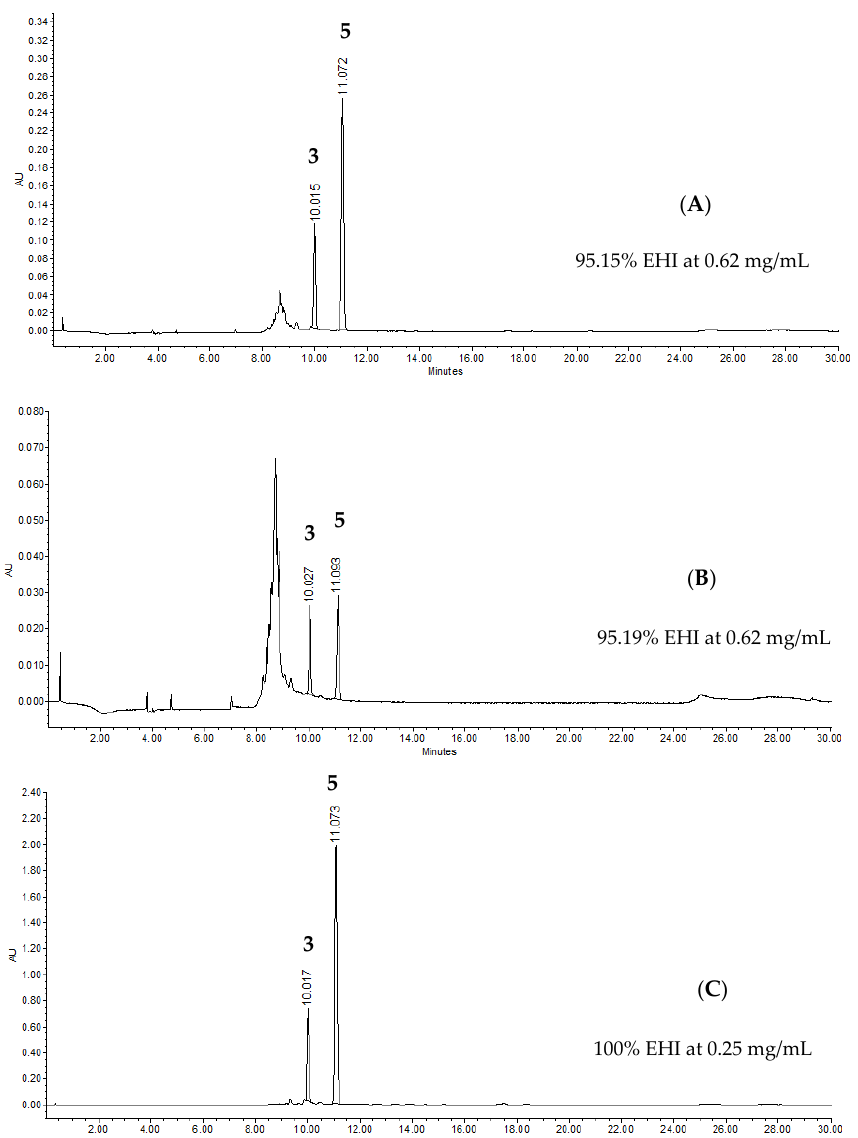
Figure 1. HPLC analysis of Pithecellobium dulce leaves showing egg hatching inhibition of Haemonchus contortus eggs. ( A ) hydroalcoholic extract (HA-E), ( B ) aqueous fraction (Aq-F) and ( C ) organic fraction (EtOAc-F). Coumaric acid ( 3 ) and luteolin 7-O-rhamnoside ( 5 ).